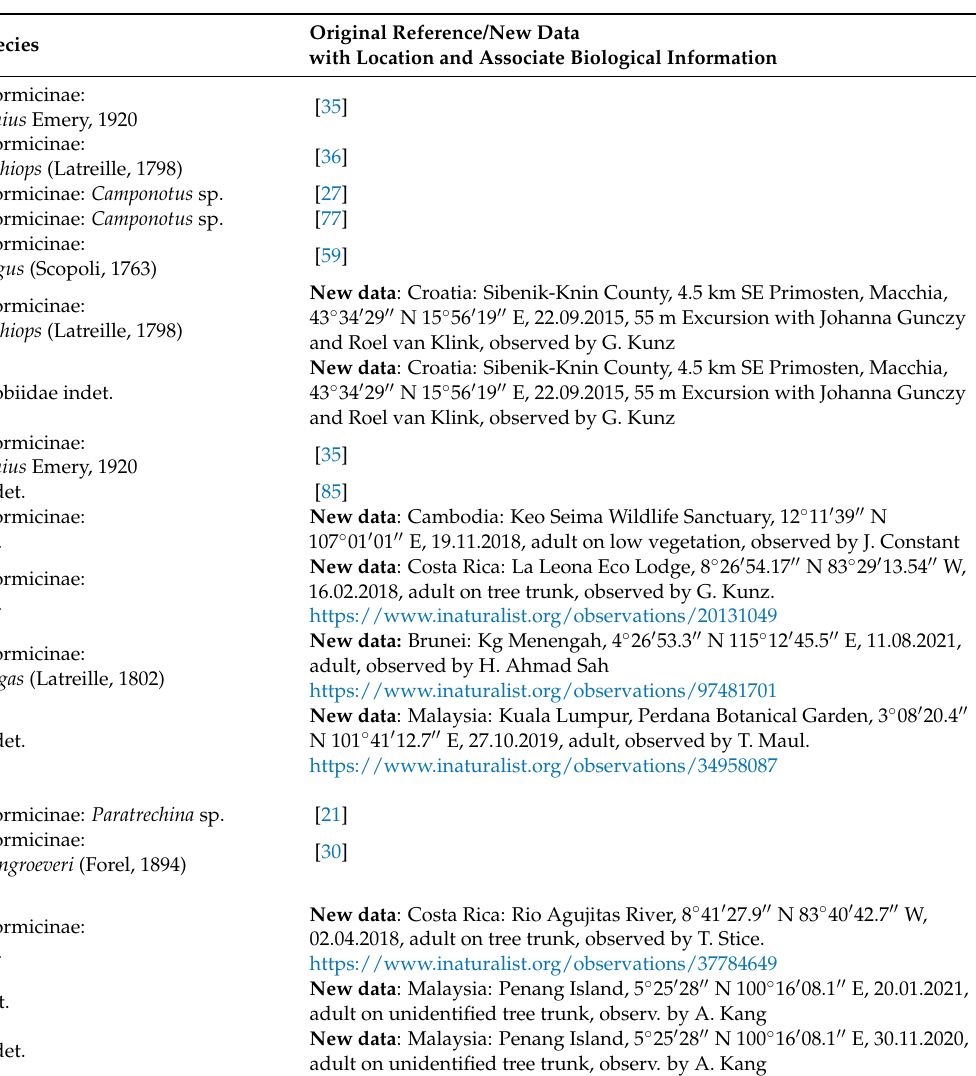
Figure 22c Issidae indet. Formicidae indet.